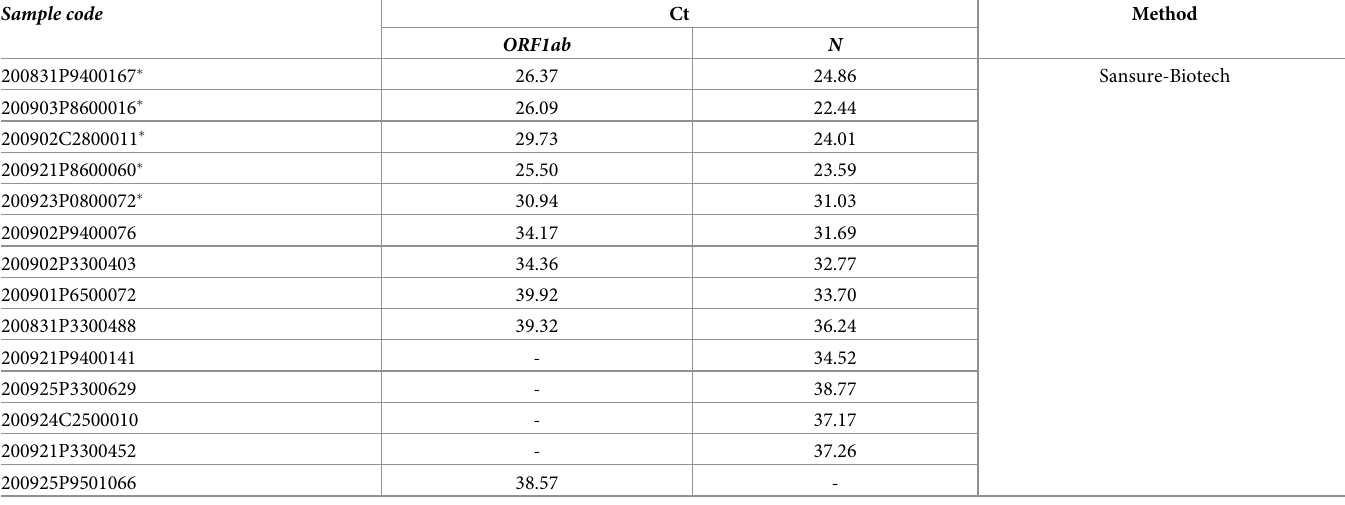
Table 1. Initial cycle threshold (Ct) values of the 14 samples used for the experimental pooling.